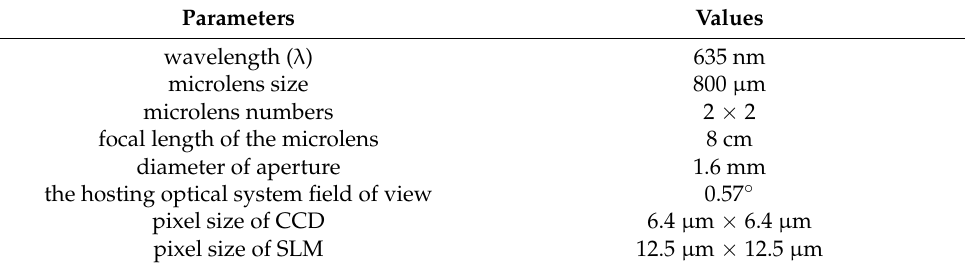
Figure 11. Experimental setup. (OA, optical attenuator; AP, aperture; POL, linear polarizer plate; BS, beam splitter; SLM, spatial light modulator; CCD, camera). Table 2. The parameters of the main optical devices in the experiment.